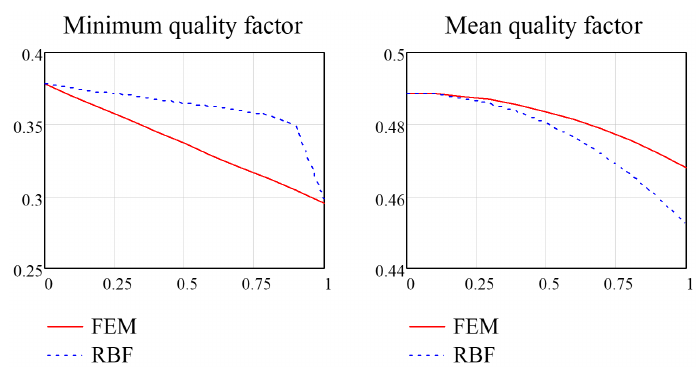
Figure 3. Mesh quality with respect to hole displacement for the case shown in Figure 2. Worst element quality ( left ) and mean mesh quality ( right